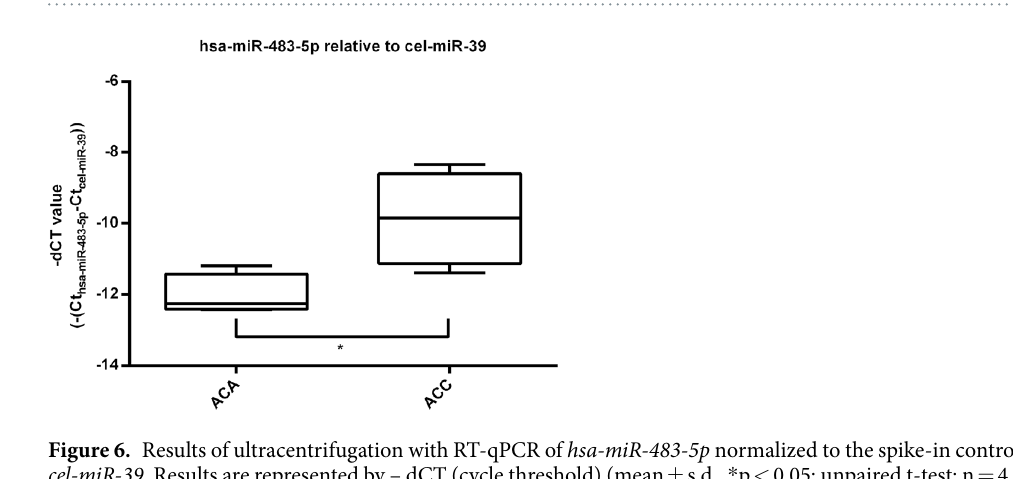
gene. We have found significanty higher expression of hsa-miR-483-5p in exosomes in ACC relative to ACA (p = 0.0221, Fig. 6).